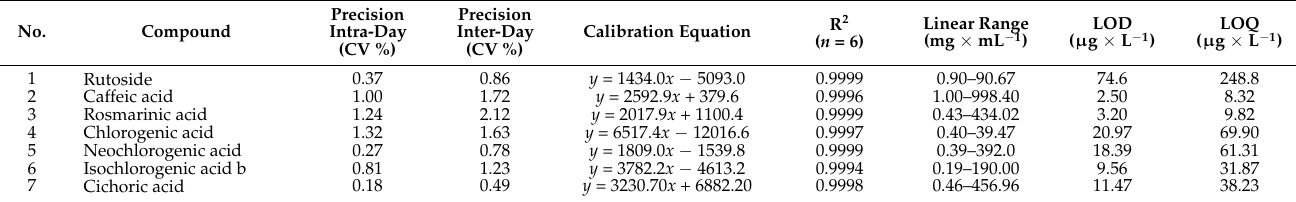
Table 9. HPLC-DAD validation parameters ( n =